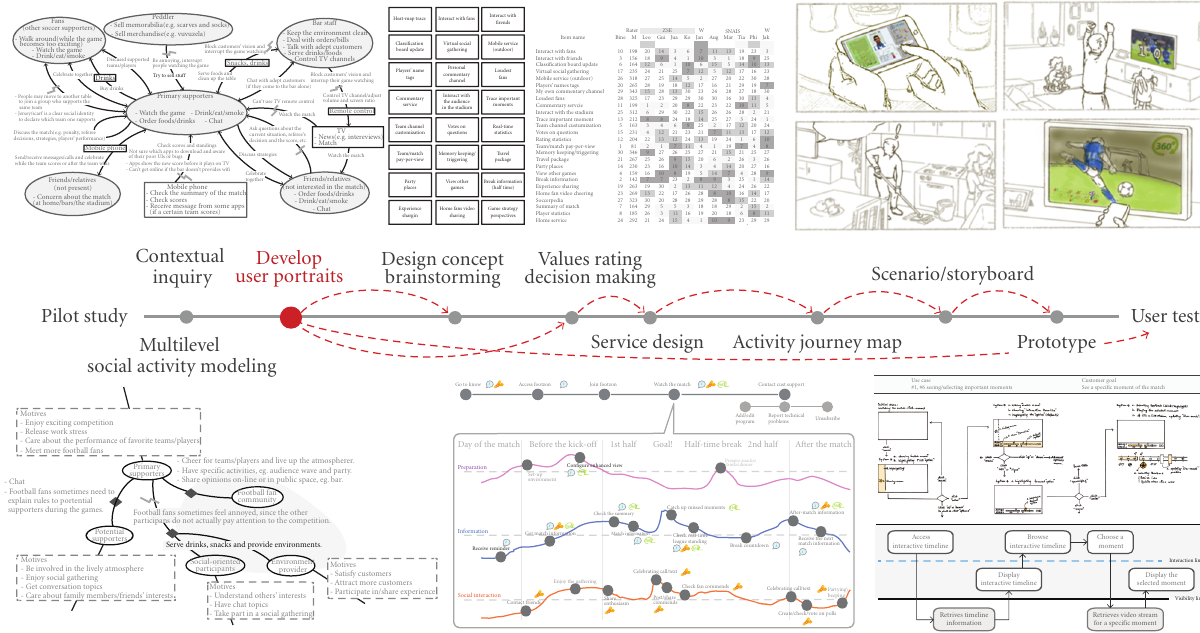
Figure 5: The uses of personas in the service design process (red